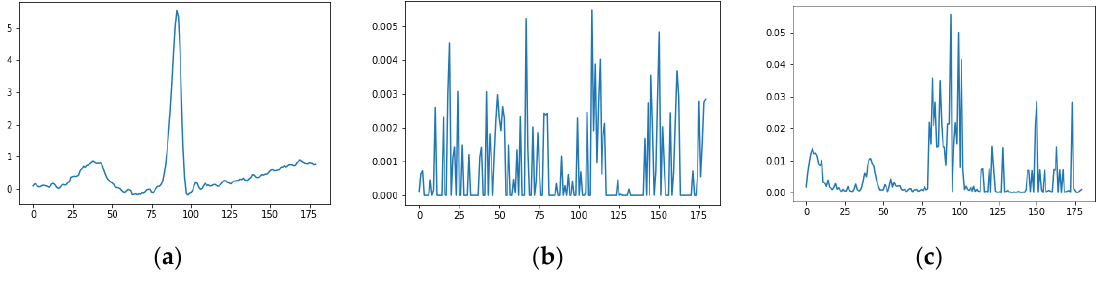
Figure 4. Comparison between LIME and B-LIME feature importance. ( a ) Original heartbeat. ( b ) LIME features. ( c ) B-LIME